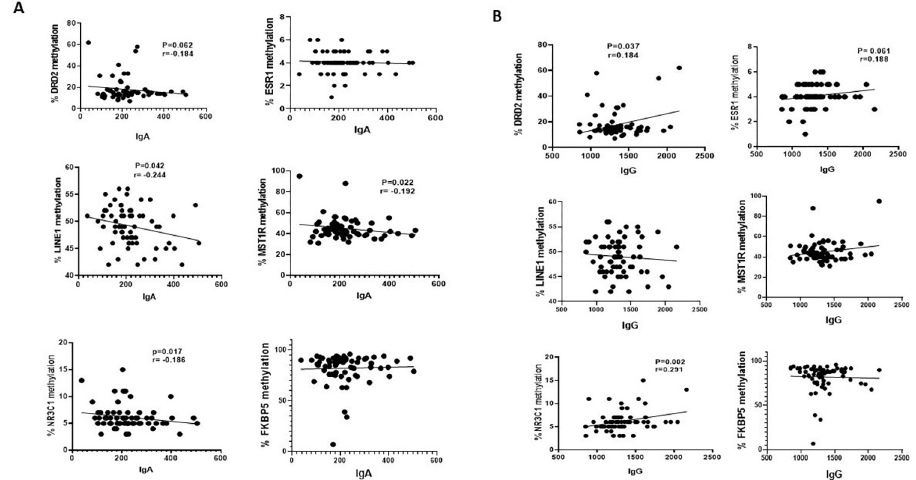
Fig 2. Quantitative DNA methylation analysis and correlation with Immune markers. The percentage of DNA methylation levels at promoter CpG island were compared with serum IgA (A) and IgG (B) levels. Y axis, percentage of methylated cytosines in the samples as obtained from pyrosequencing. X axis, IgA, or IgG serum levels. P value is indicated for each gene (Mann-Whitney T-test).